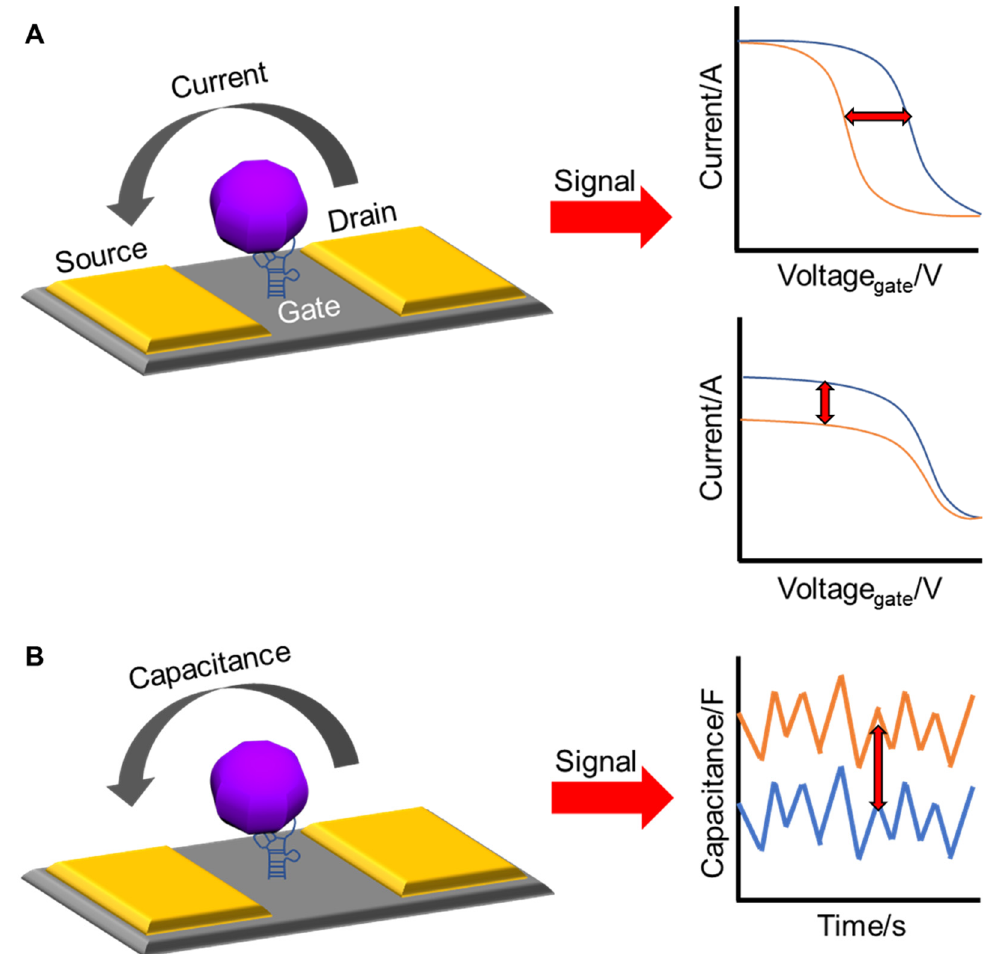
Figure 4. Schematics of ( A ) FET-based biosensor showing the change in voltage and current before and after bonding and ( B ) capacitive biosensor showing the change in capacitance before and after bonding.